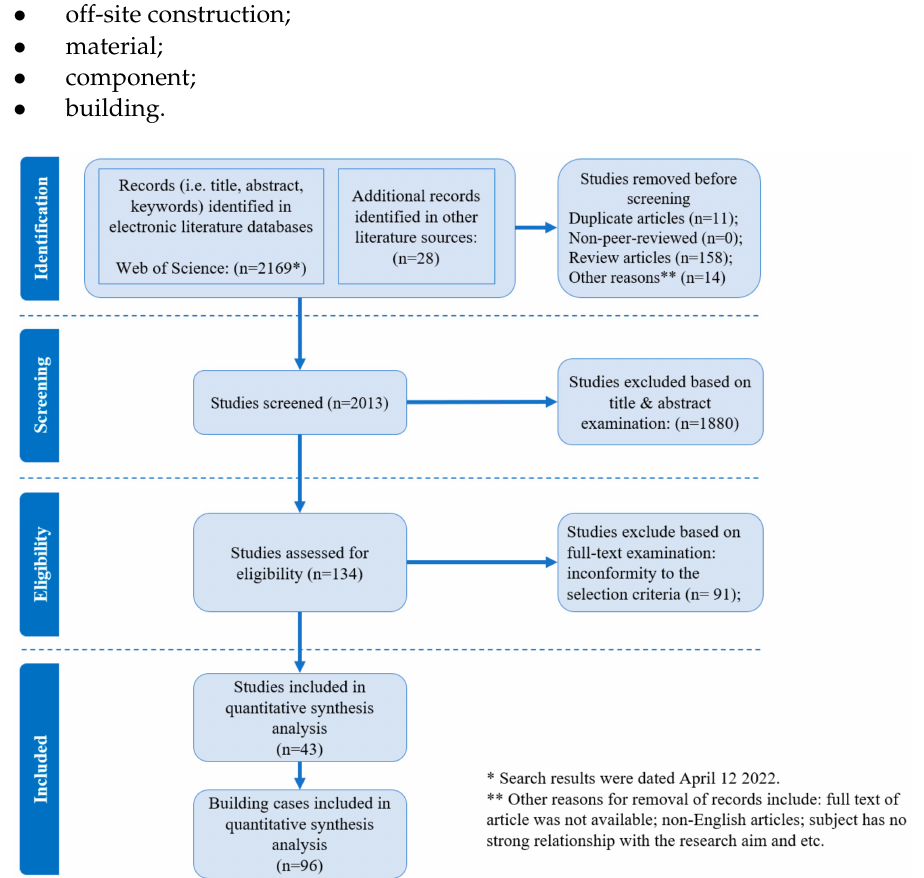
Figure 1. Flowchart of literature selection (conformed to PRISMA